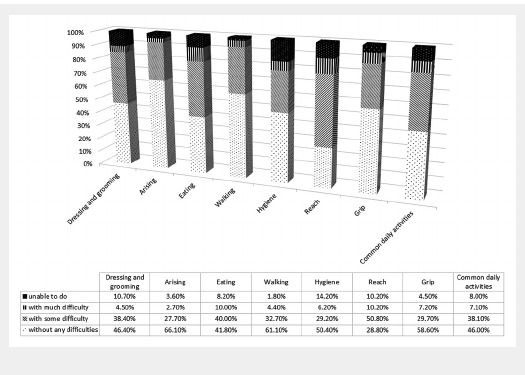
Table 1: Demographic and clinical features of the patients with systemic